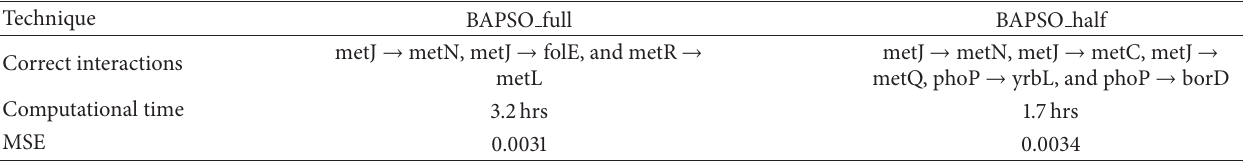
Table 7: True positives obtained for the GRN consisting of 20